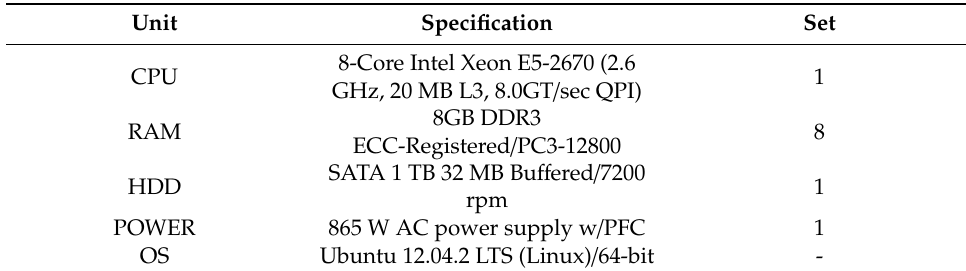
Table 6. Performance information of computer for data analysis.